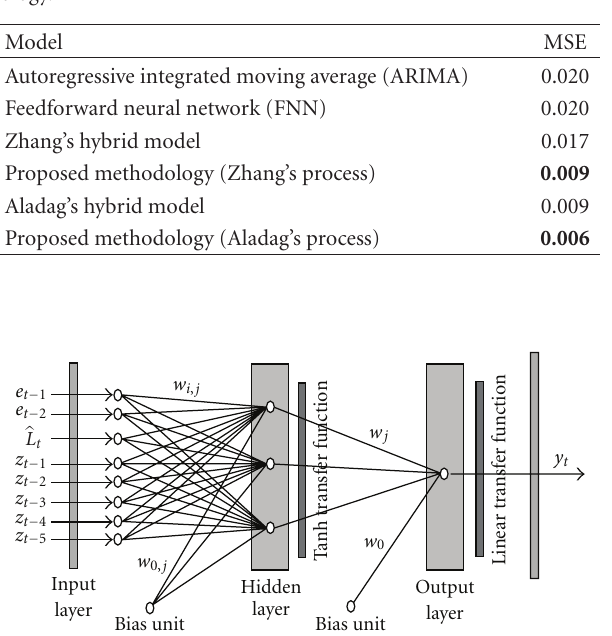
Table 1: Comparison of the performance of the proposed method- ology.